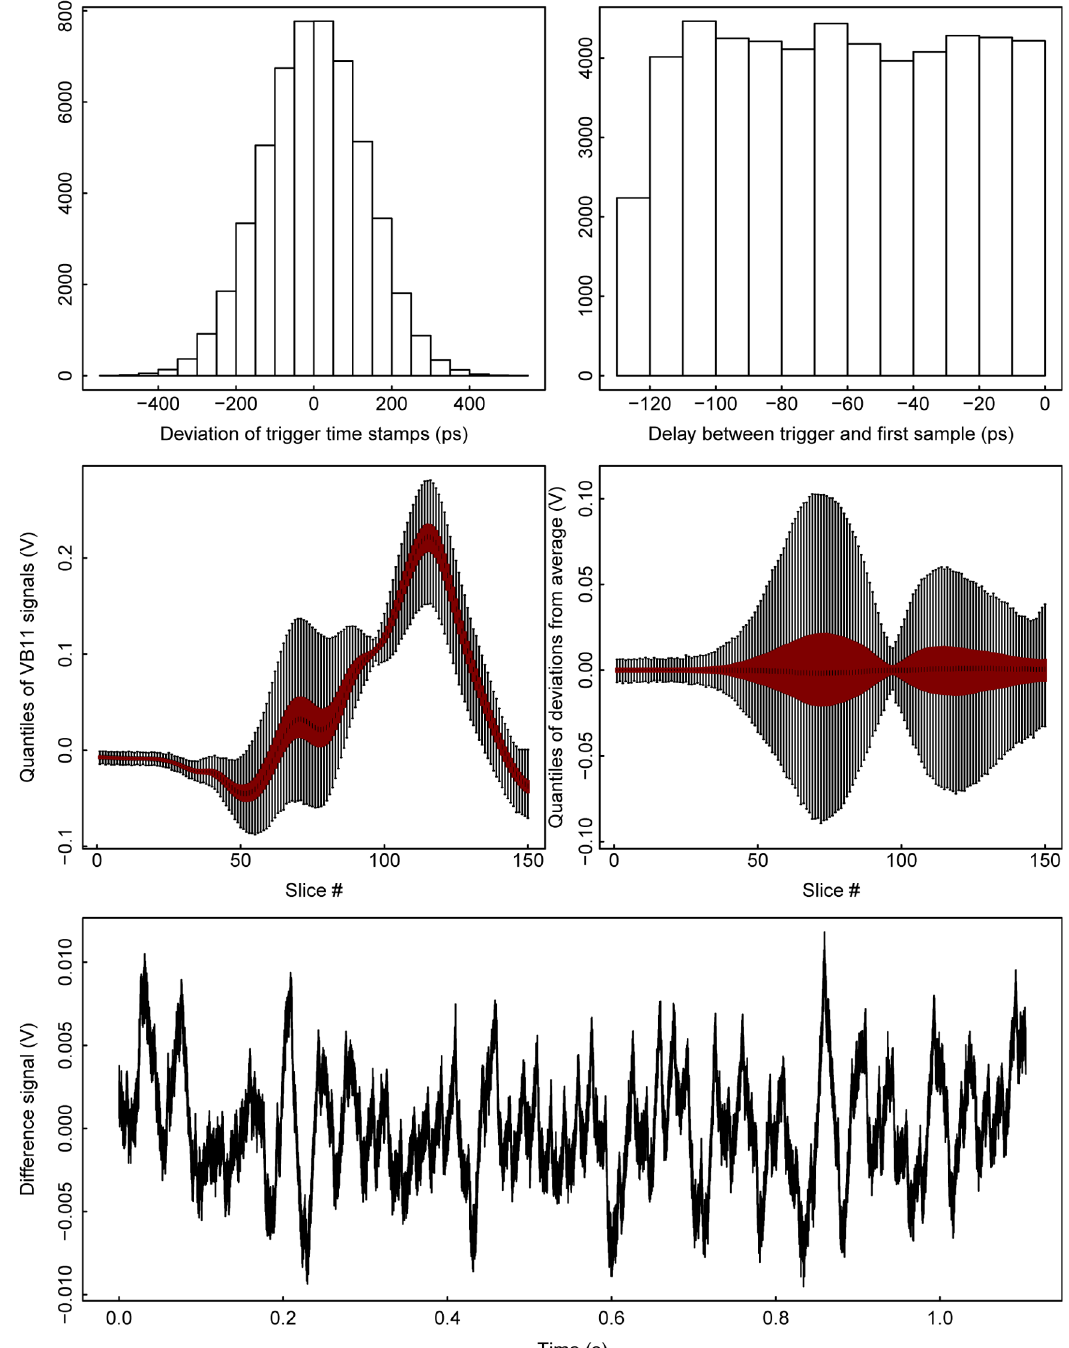
FIG. 4. Summary plots for one sample data set (Store 7754 at 21:41): difference between recorded trigger time and nominal revolution time (top left); recorded offset between trigger time stamp and first sample (top right); quantiles (minimum, 25%–75% in red, maximum) of digitized signals over all 52 707 turns, for each slice (center left); quantiles of digitized signals after subtracting each slice’s average; average difference signal for the signal slices (41–95 and 99–147) over the course of the